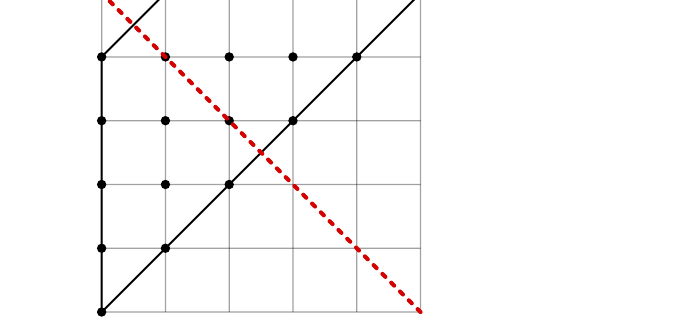
Figure 16. An example of a trapezoid for which you can find a non-anomalous diagonal line